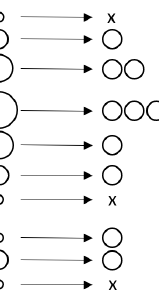
Figure 6. Example of how resampling changes a set of 10 weighted particles ( left ) into a new set of 10 uniformly weighted particles ( right ). Some particles are duplicated, some particles are never selected and disappear (represented by the